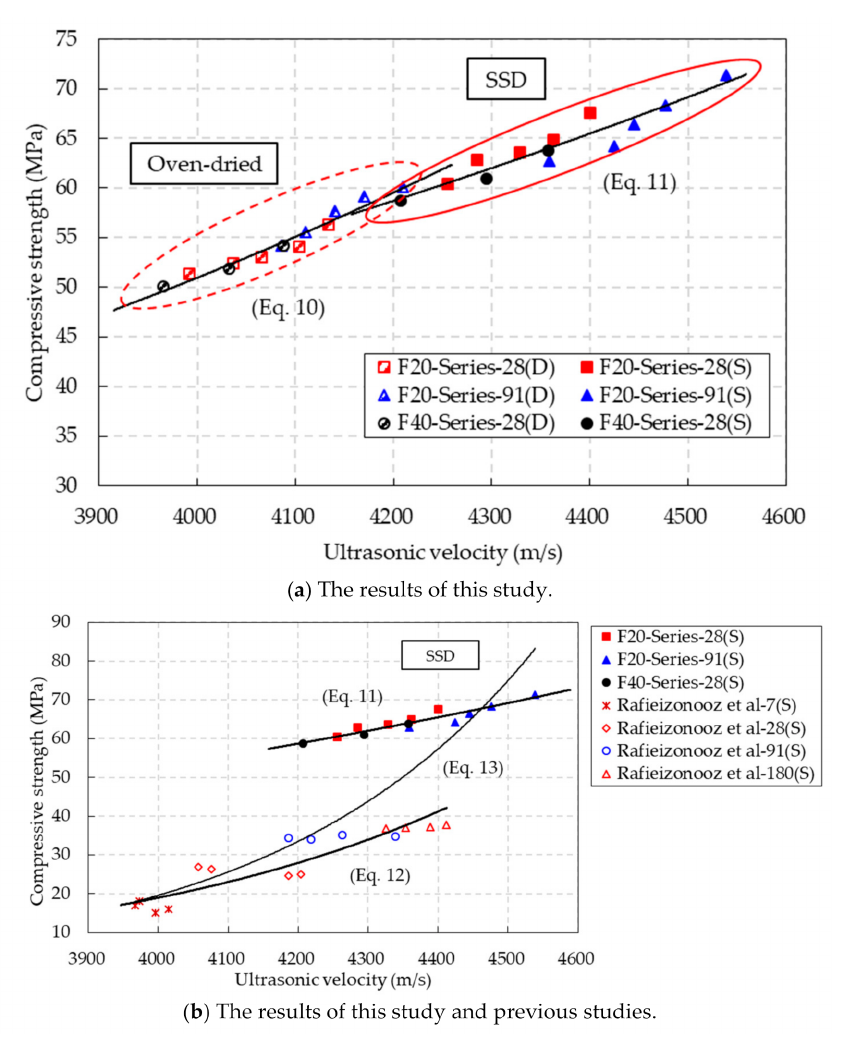
Figure 15. Relationships between the ultrasonic velocity and compressive strength under SSD